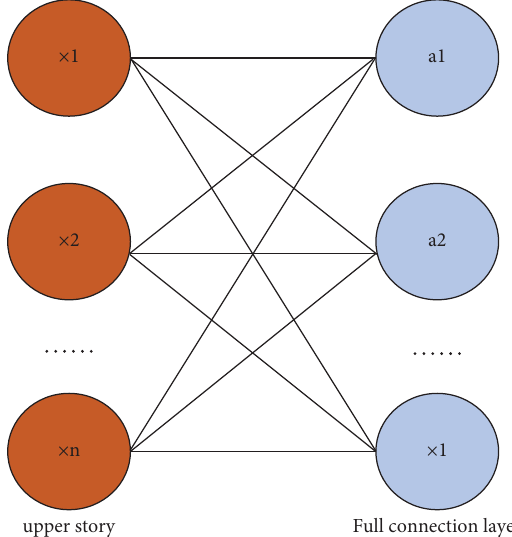
Figure 7: Schematic diagram of the fully connected